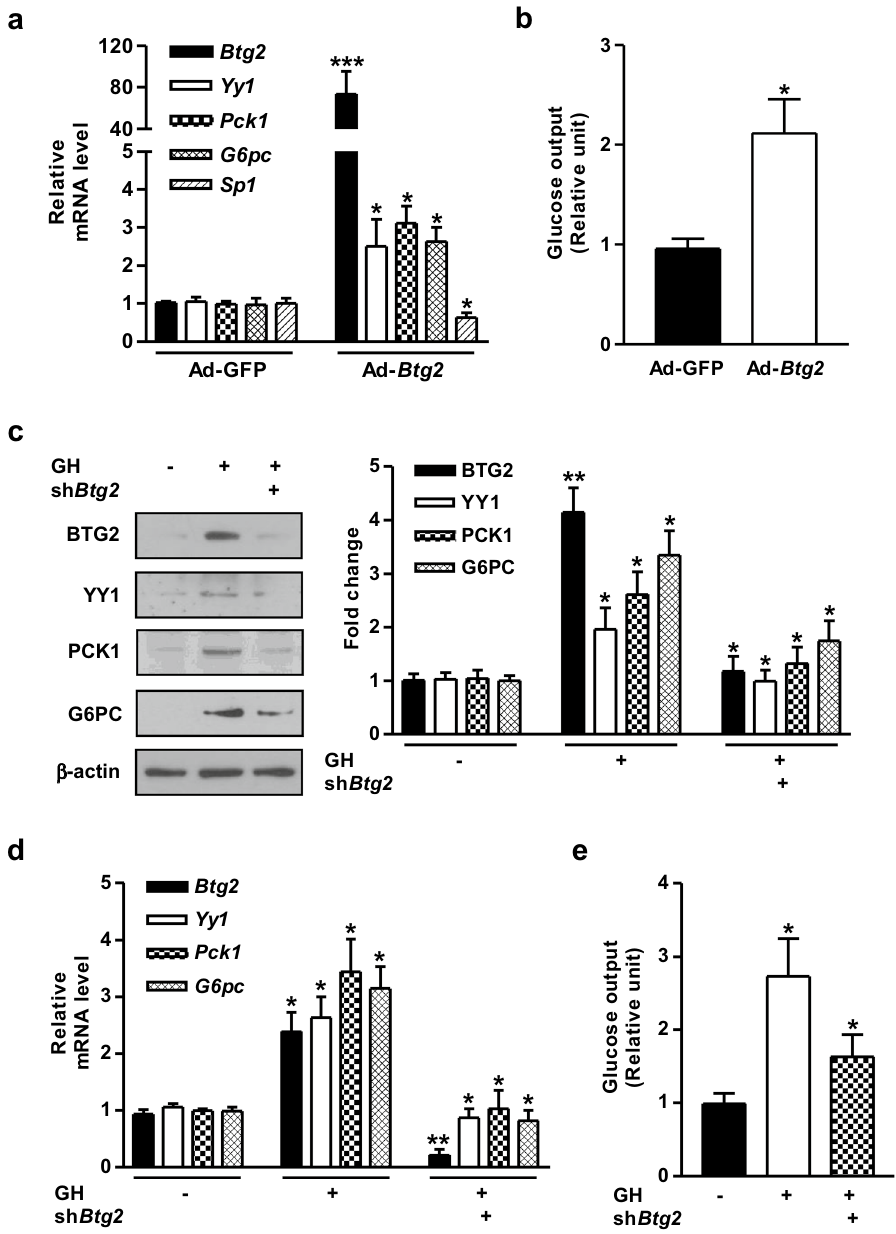
Figure 2. Induction of hepatic gluconeogenesis by GH is BTG2 dependent. ( a ) MPHs were infected with Ad-GFP and Ad- Btg2 at a multiplicity of infection (MOI) of 60 for 36 h. qPCR analysis was performed to examine the expression of indicated genes using specific primers. Sp1 is a negative control. ( b ) Glucose production assay in MPHs infected with Ad-GFP and Ad- Btg2 for 36 h. ( c ) Whole cell extracts from MPHs of the indicated groups were subjected to immunoblot analysis with the indicated antibodies. ( d ) MPHs were infected with lentiviral-sh Btg2 (sh Btg2 ) at 60 MOI for 36 h, followed by GH treatment for 3 h. Total RNAs were utilized for qPCR analysis with gene-specific primers. ( e ) Glucose production assay in MPHs infected with sh Btg2 for 36 h, and then treated with GH for 3 h. * P < 0.05, ** P < 0.01, and *** P < 0.001 vs. untreated control, Ad-GFP, or GH-treated